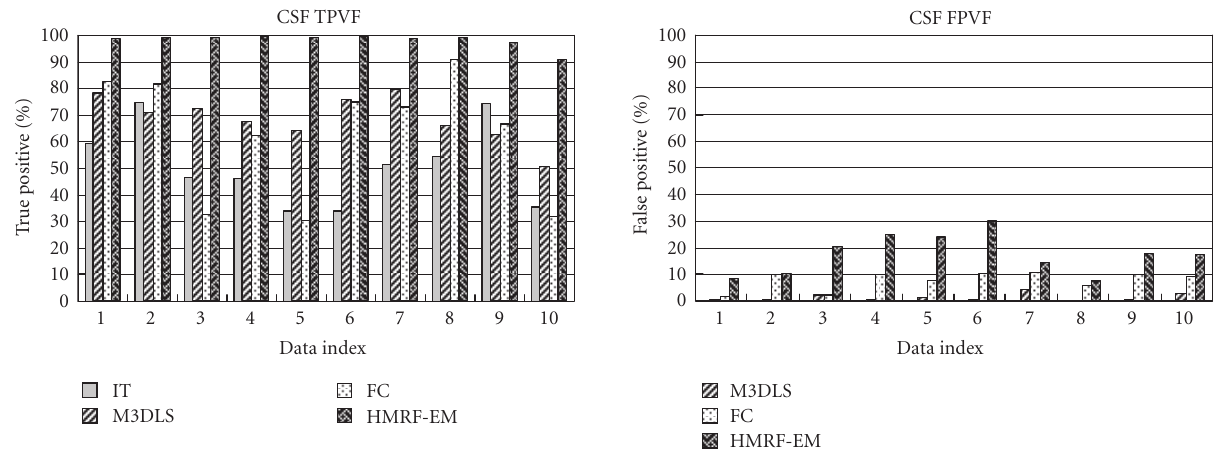
Figure 10: TPVF and FPVF errors for segmentation of CSF.